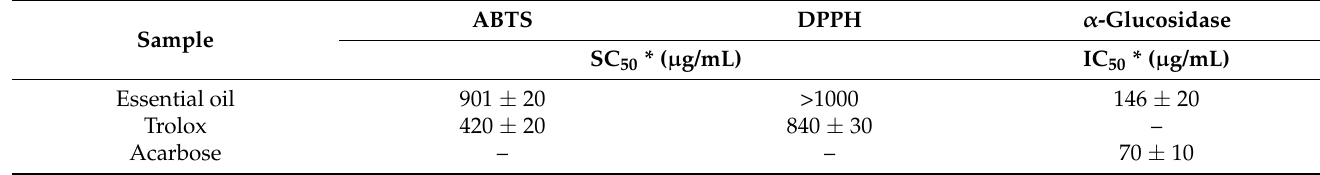
Table 3. Antioxidant activity and α -glucosidase inhibition properties of essential oils from H. racemosum